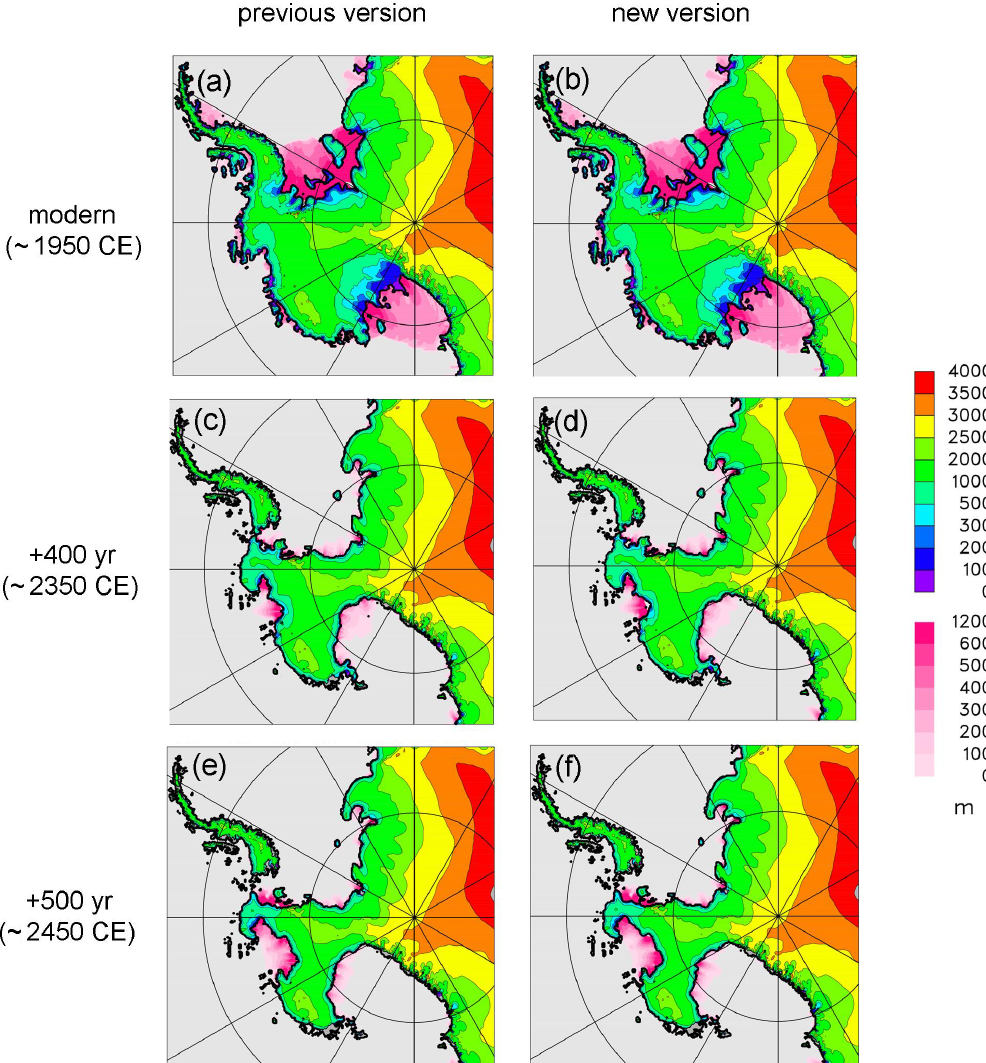
Figure 9. Spatial maps of simulated future West Antarctic ice retreat with RCP8.5 forcing, without hydrofracturing or cliff failure, showing grounded ice surface elevations (m, rainbow scale) and floating ice thicknesses (m, pink scale). (a, b) At year 0 ( ∼ 1950CE). (c, d) At year 400 ( ∼ 2350CE). (e, f) At year 500 ( ∼ 2450CE). (a, c, e) Previous model version. (b, d, f) New model